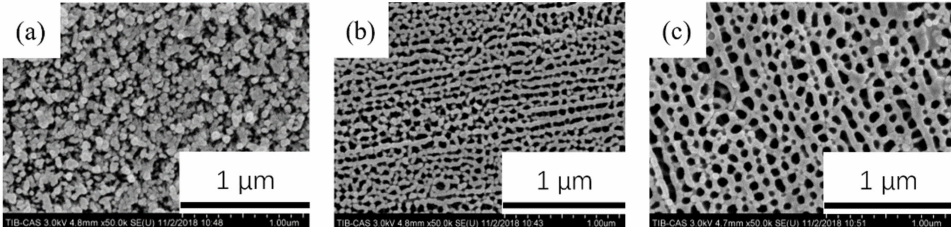
Figure 11. SEM images of 1060 anodic oxide films at different anodic oxidation voltages: ( a ) 10 V; ( b ) 30 V; ( c ) 50